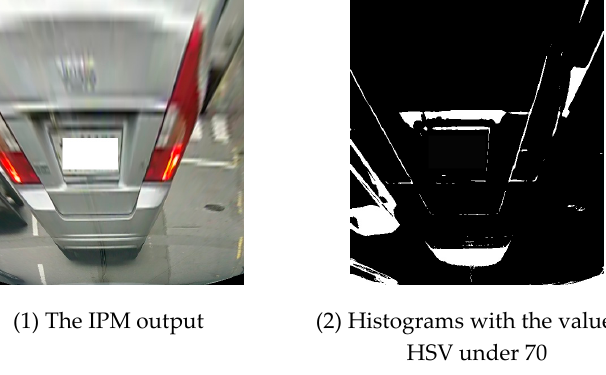
Figure 4. Car shadow detection with color histogram.